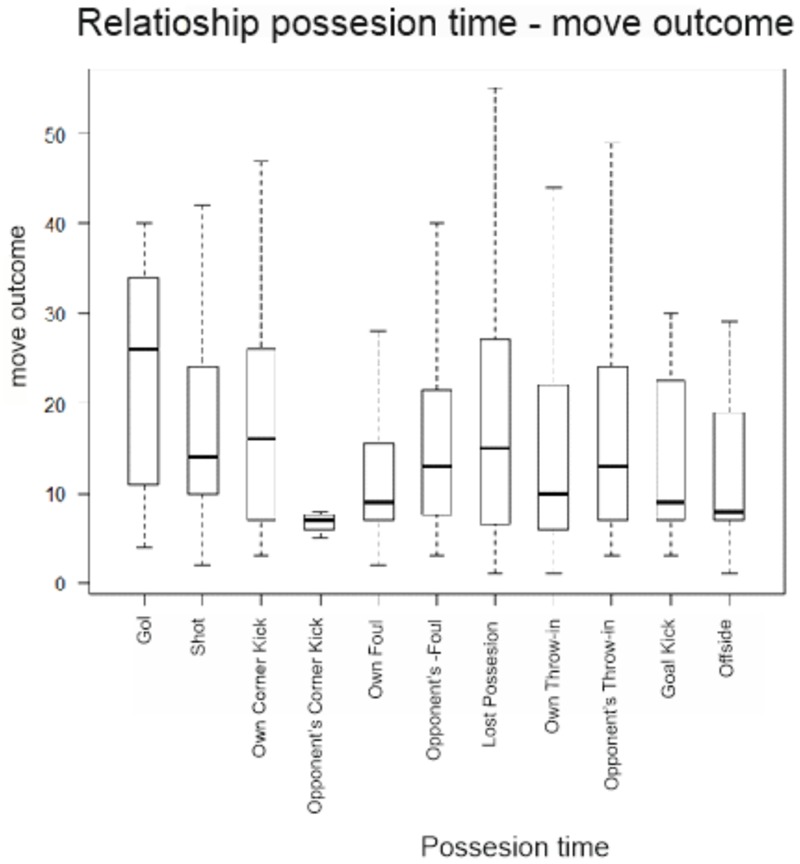
Move outcome and possession time diagram box.